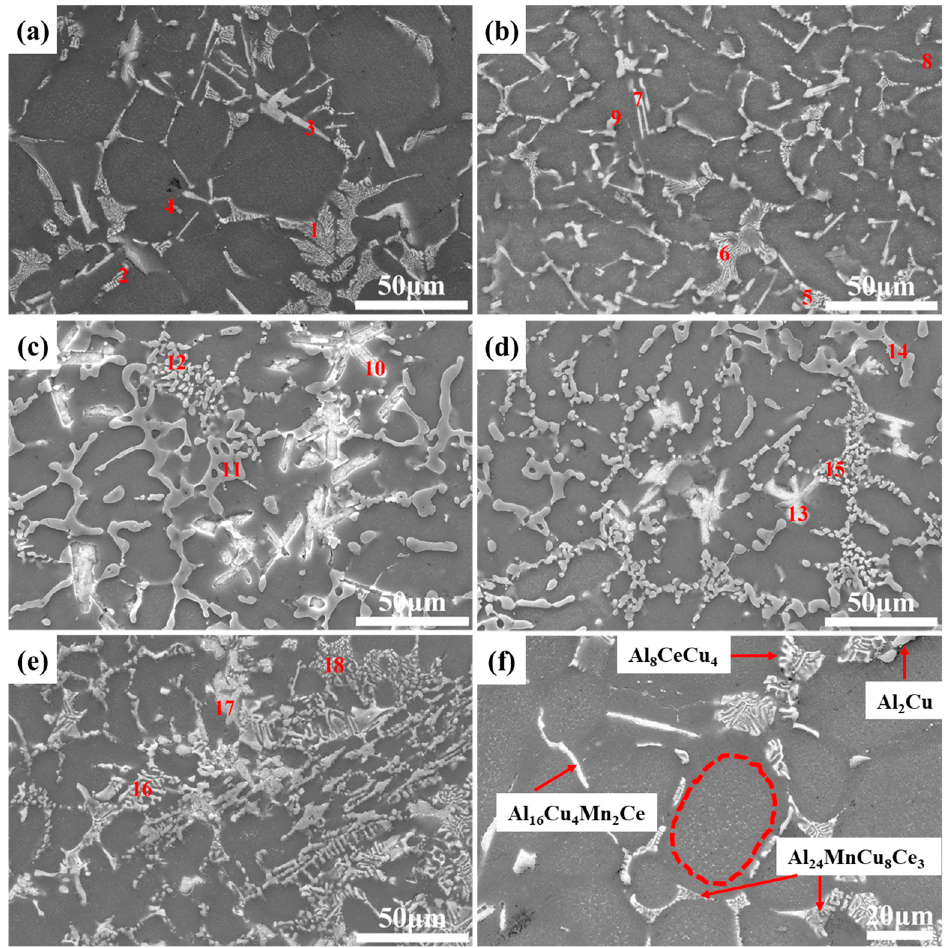
Figure 4. SEM images of heat-treated alloys: ( a ) 0 Ni alloy, ( b ) 0.5 Ni alloy, ( c ) 1.0 Ni alloy, ( d ) 2.0 Ni alloy, ( e ) 4.0 Ni alloy, ( f ) the nano-phases inside grains in the 0 Ni alloy. In the 1.0 Ni alloy and 2.0 Ni alloy, the coarse blocky-like Al 16 Cu 4 Mn 2 Ce phase appears (Label 10 and 13), but the thermally stable Al 8 CeCu 4 and Al 24 MnCu 8 Ce 3 phases